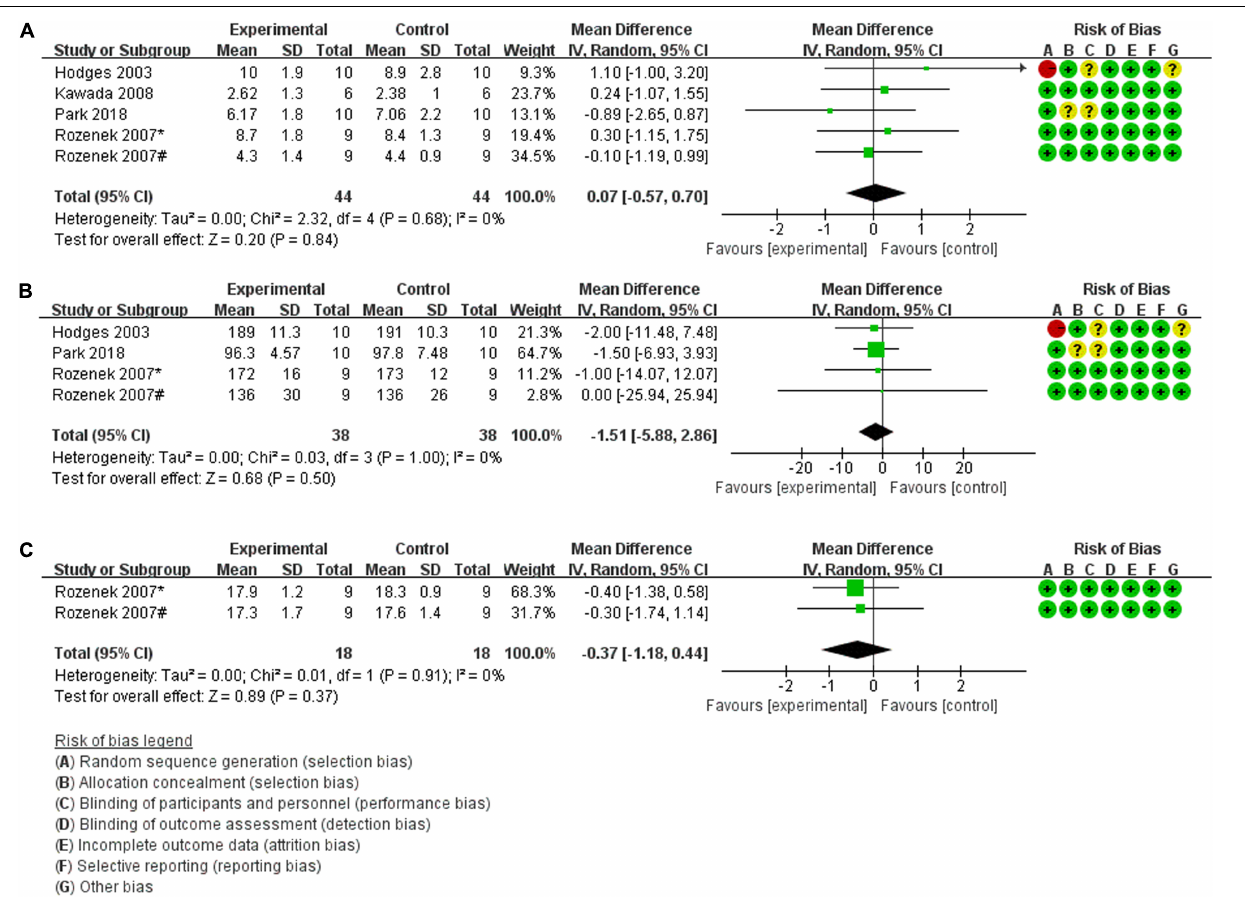
FIGURE 2 | Forest Plot of the Comparison of the effects of pre-exercise HBO 2 on exercise performance. (A) Blood lactate concentration index, (B) peak heart rate index, (C) rating of perceived exertion index; *: experiment 1; #: experiment